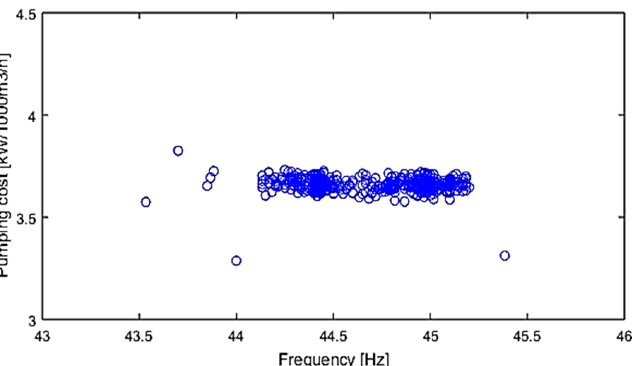
Figure 11. The characteristic F = f ( C_p i,n ) for the hydraulic regime with two pumps in operation.